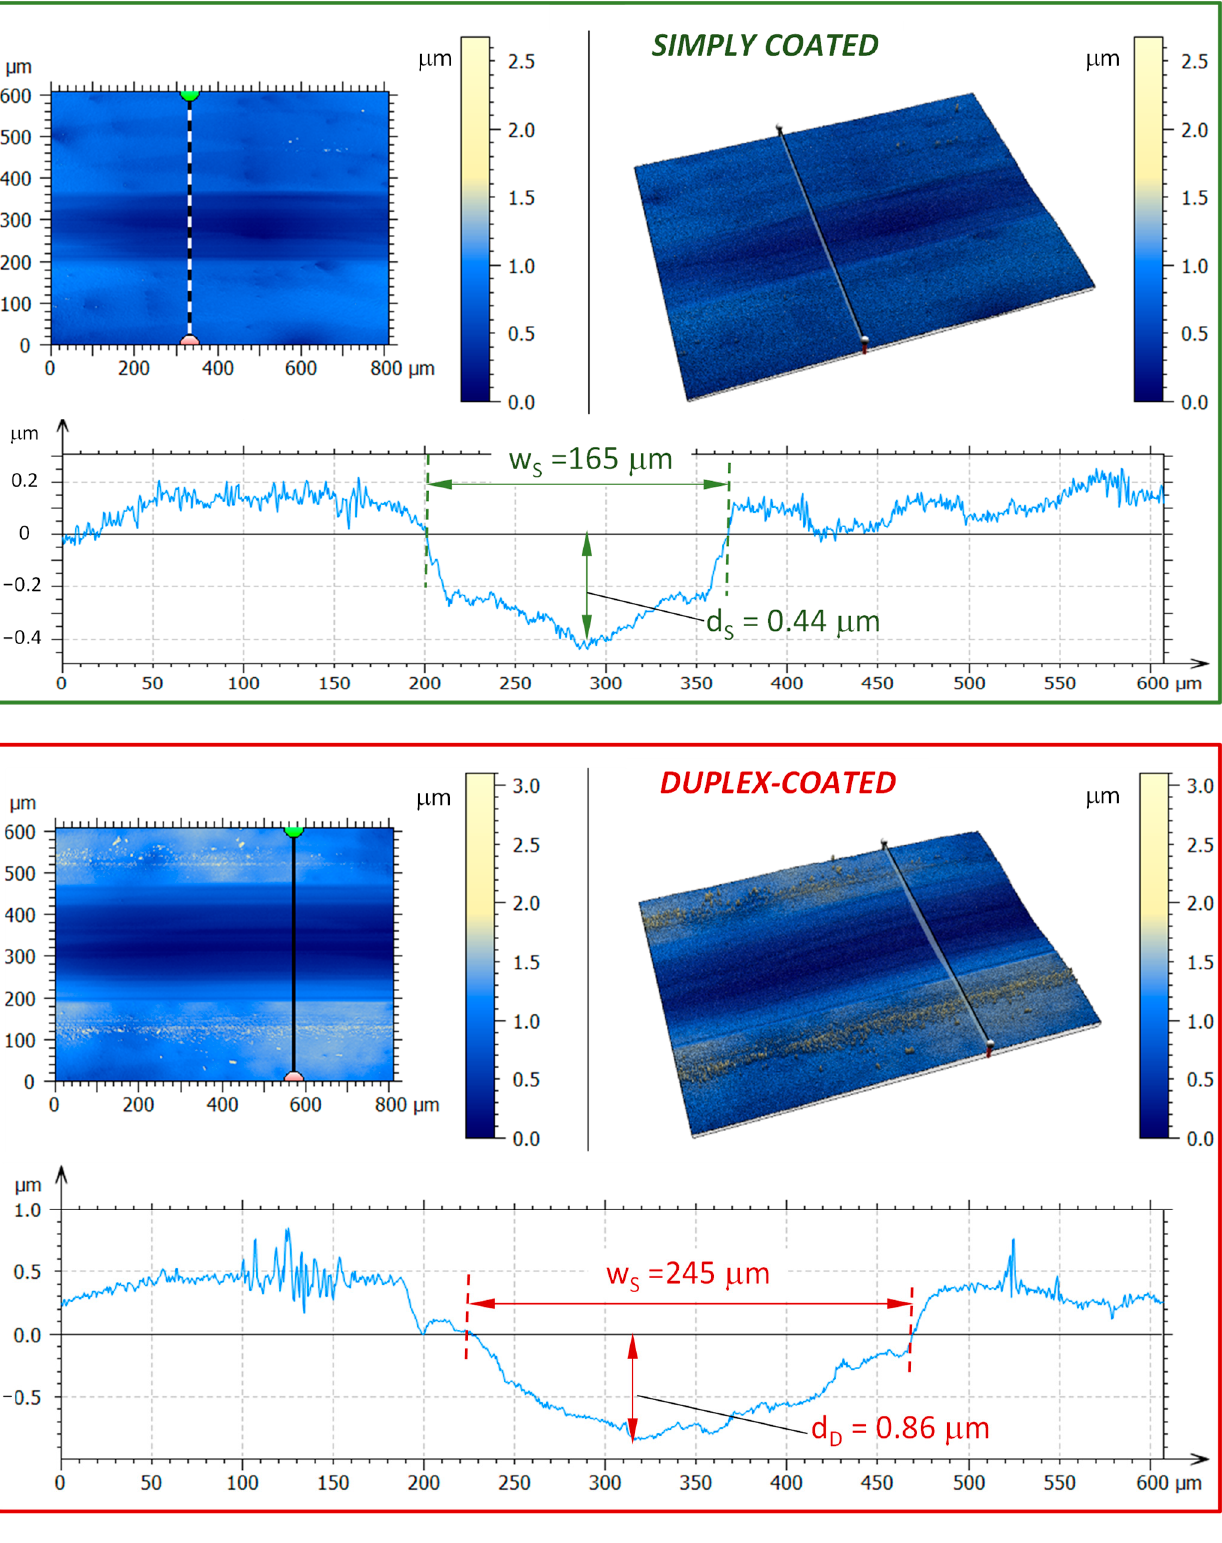
Figure 7. 2D and 3D profile of the wear track on the simple-coated ( up ) and the duplex-coated ( down ) discs. ( down )